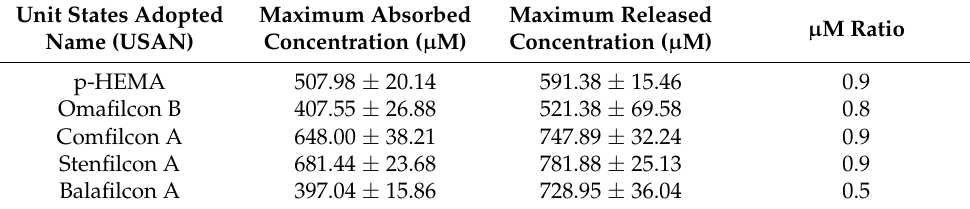
Table 3. The yield of contact lenses loaded with 5-MCA-NAT as a drug delivery